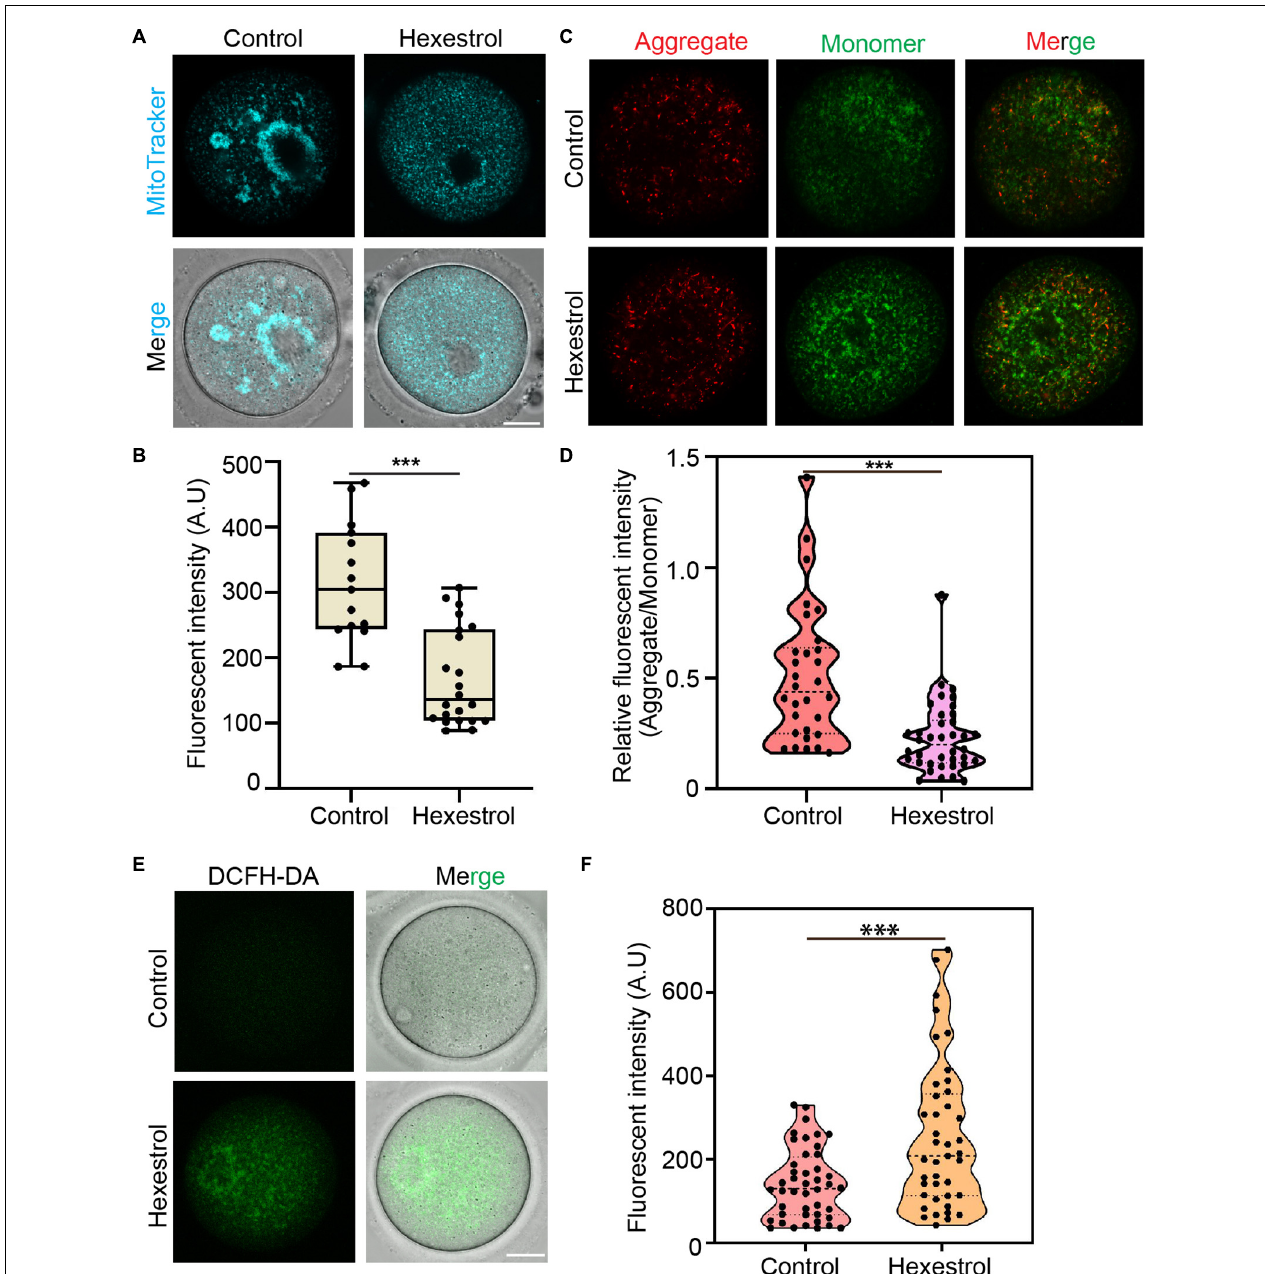
FIGURE 4 | HES affects mitochondrial function in oocytes. (A) Mitochondria distribution was examined in control and HES-exposed oocytes. Scale bar, 20 µ m. (B) Fluorescent intensity of Mito-Tracker was quantified in control and HES-exposed oocytes. *** P < 0.001. (C) Representative images of JC-1 kit staining in control and HES-exposed oocytes. Scale bar, 20 µ m. (D) Mitochondrial membrane potential was recorded after HES exposure (Aggregate/Monomer). *** P < 0.001. (E) Representative images of ROS levels in control and HES-exposed oocytes. Scale bar, 20 µ m. (F) Fluorescent intensity of ROS was analyzed in control and HES-exposed oocytes. *** P < 0.001. Data are represented as mean ± SD from at least three independent